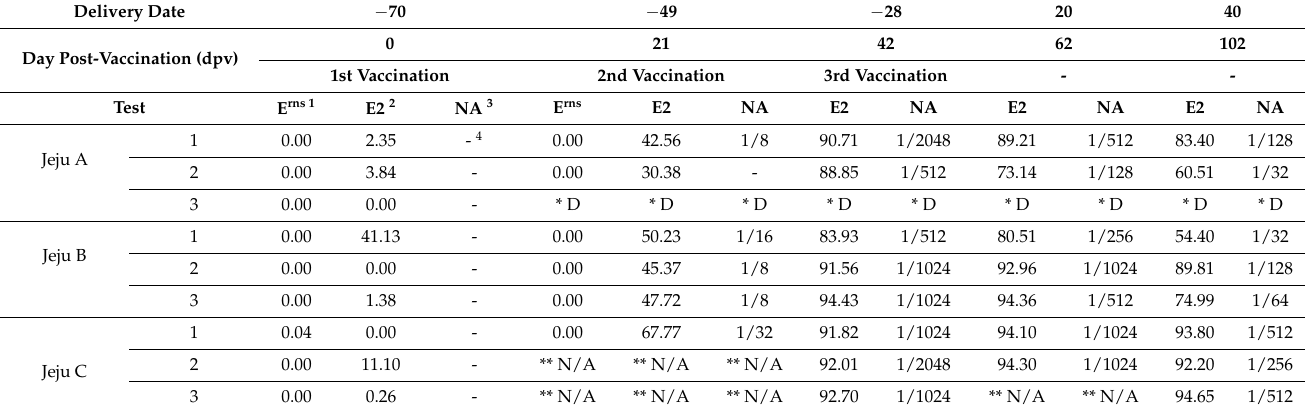
Table 1. Serological analysis of serum samples from pregnant sows on farms on Jeju